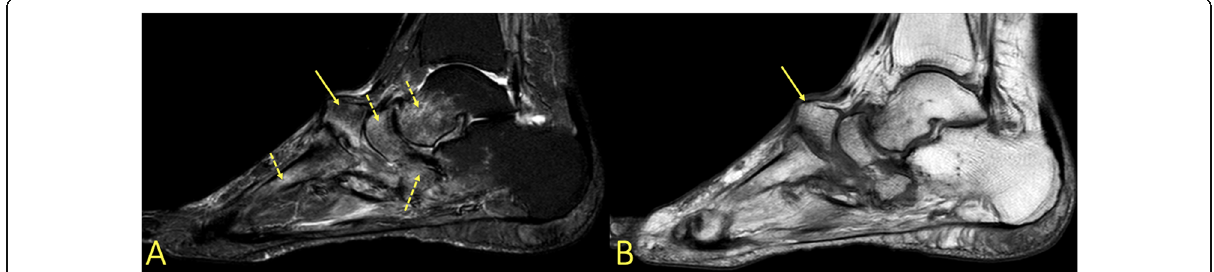
Fig. 29 A 28-year-old male presented with ankle pain for 3 months without a history of trauma and suspicion of tumor. There was extensive bone marrow edema in all bones of the foot, most pronounced in the talus (dashed arrow on a ) and calcaneus (arrow on b ). CRMO was diagnosed after a couple of